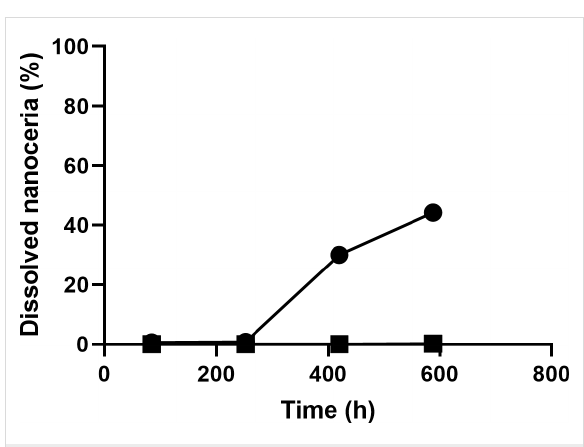
Figure 9: High-temperature exposure decreased the dissolution of solvothermally synthesized nanoceria. Solid circles represent solvothermally synthesized nanoceria (non-calcined) and squares the calcined form. Results are the mean of two observations.